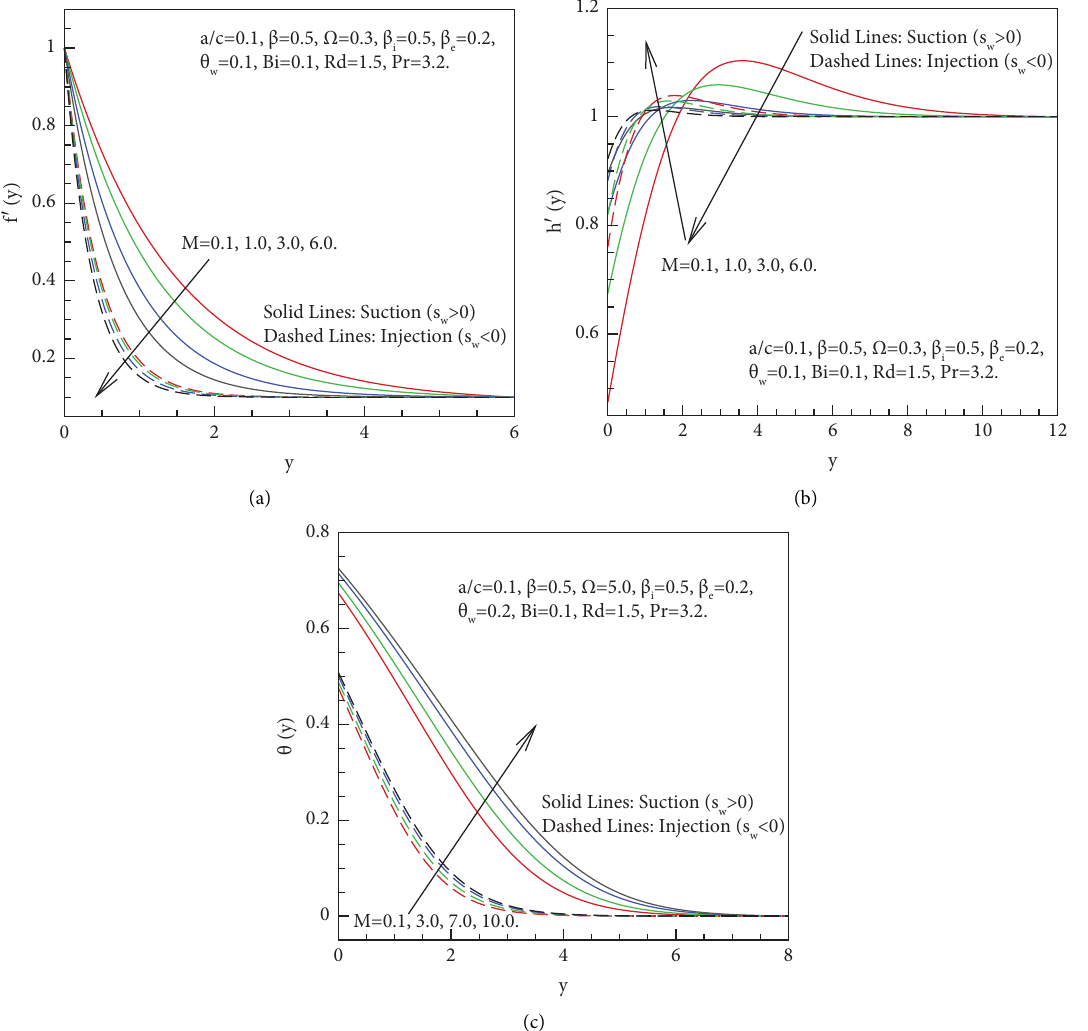
Figure 5: (a) Velocity distribution f ′ ( y ) , (b) velocity distribution h ′ ( y ) , and (c) temperature distribution θ ( y ) for magnetic feld parameter M